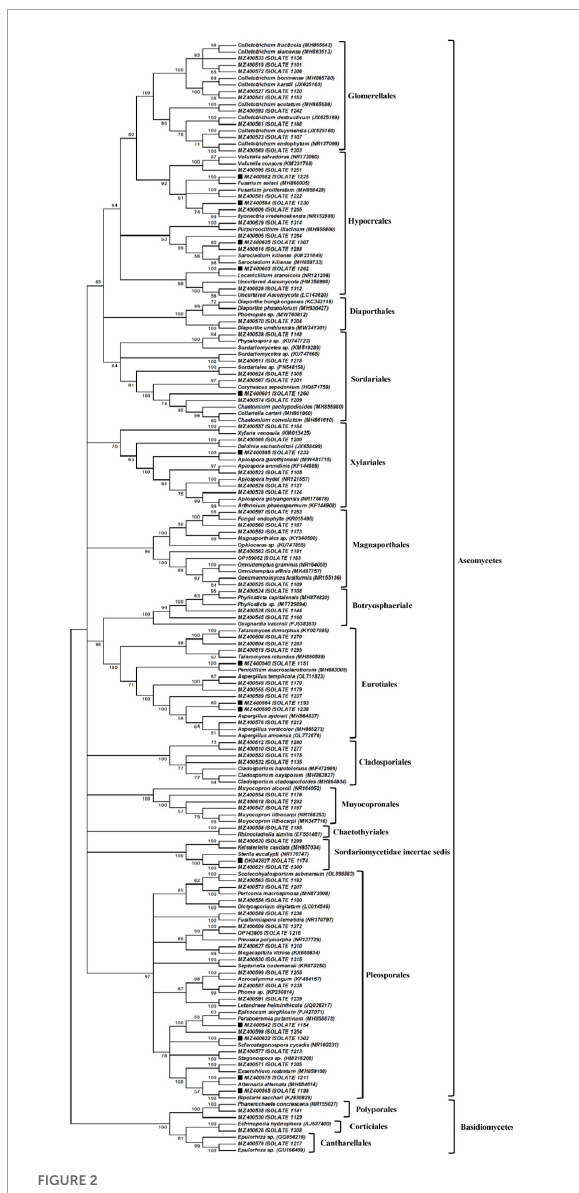
FIGURE2 Neighbor-joining (NJ) analysis revealing the phylogenetic relationships of endophytic fungi associated with Nervilia fordii . The NJ phylogenetic tree without outside groups includes a total of 169 fungal sequences, in which 85 sequences from our study, 84 reference sequences of close relatives from the NCBI database. Bootstrap support values are indicated for major nodes having values ≥ 50%. The names of 16 different groups are shown in bold letter such as: Glomerellales, Hypocreales, Diaporthales, Sordariales, Magnaporthales, Xylariales, Botryosphaeriale, Eurotiales, Cladosporiales, Muyocopronales, Chaetothyriales, Sordariomycetidae incertae sedis, Pleosporales, Polyporales, Corticiales, and Cantharellales. The solid square ( (cid:4) ) represents the isolates with antimicrobial activity.